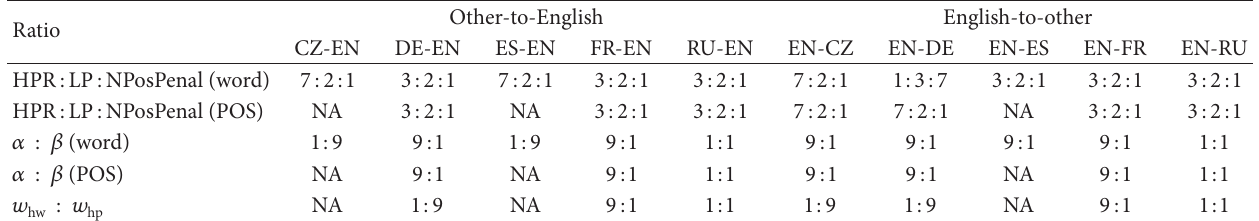
Table 7: The tuned weight values in hLEPOR.